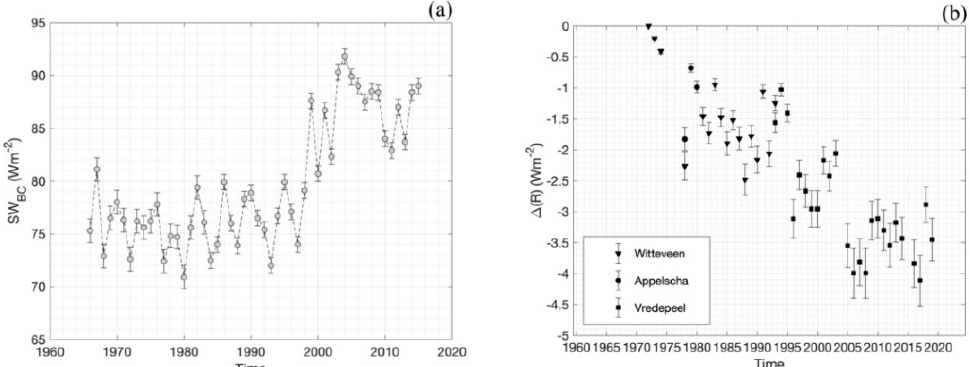
Figure 4. ( a ) Absolute cloud base proxy radiation as described by Boers et al. [9] over the indicated years averaged for five measuring sites. ( b ) Change in solar irradiance as deduced from the decrease in CDNC (Figure 3b).